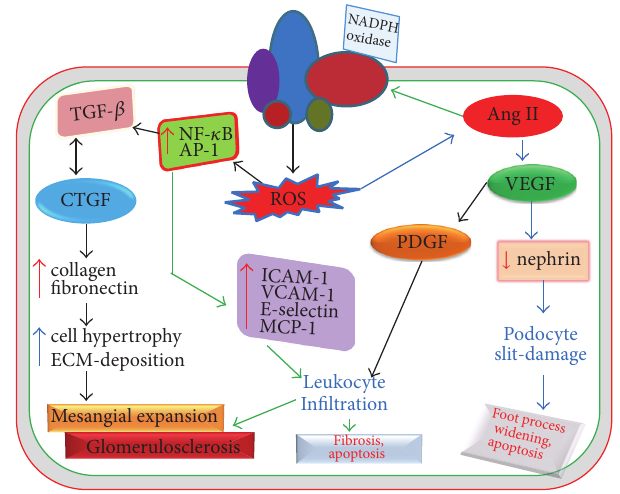
Figure 4: Major signaling pathways for induction of ECM accu- mulation following mesangial expansion, increased GBM, glomeru- losclerosis, and fibrosis. This results in subsequent end-stage renal